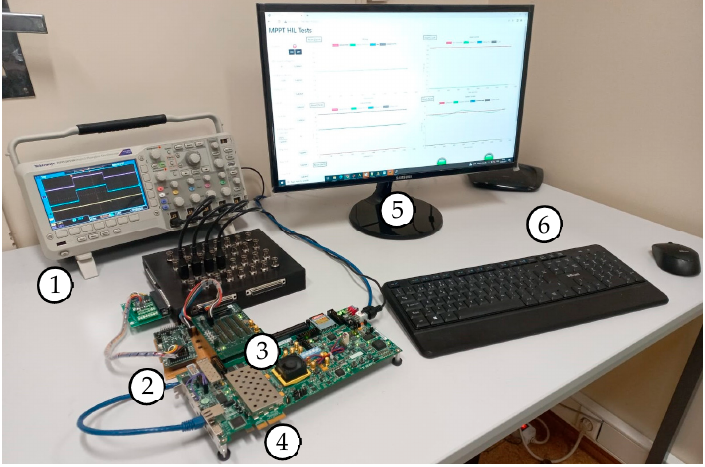
Figure 10. MPPT HIL test setup. 1—Oscilloscope; 2—DAC7558EVM; 3—expansion board XM105; 4—FPGA Xilinx ZC706; 5—computer; 6—router.